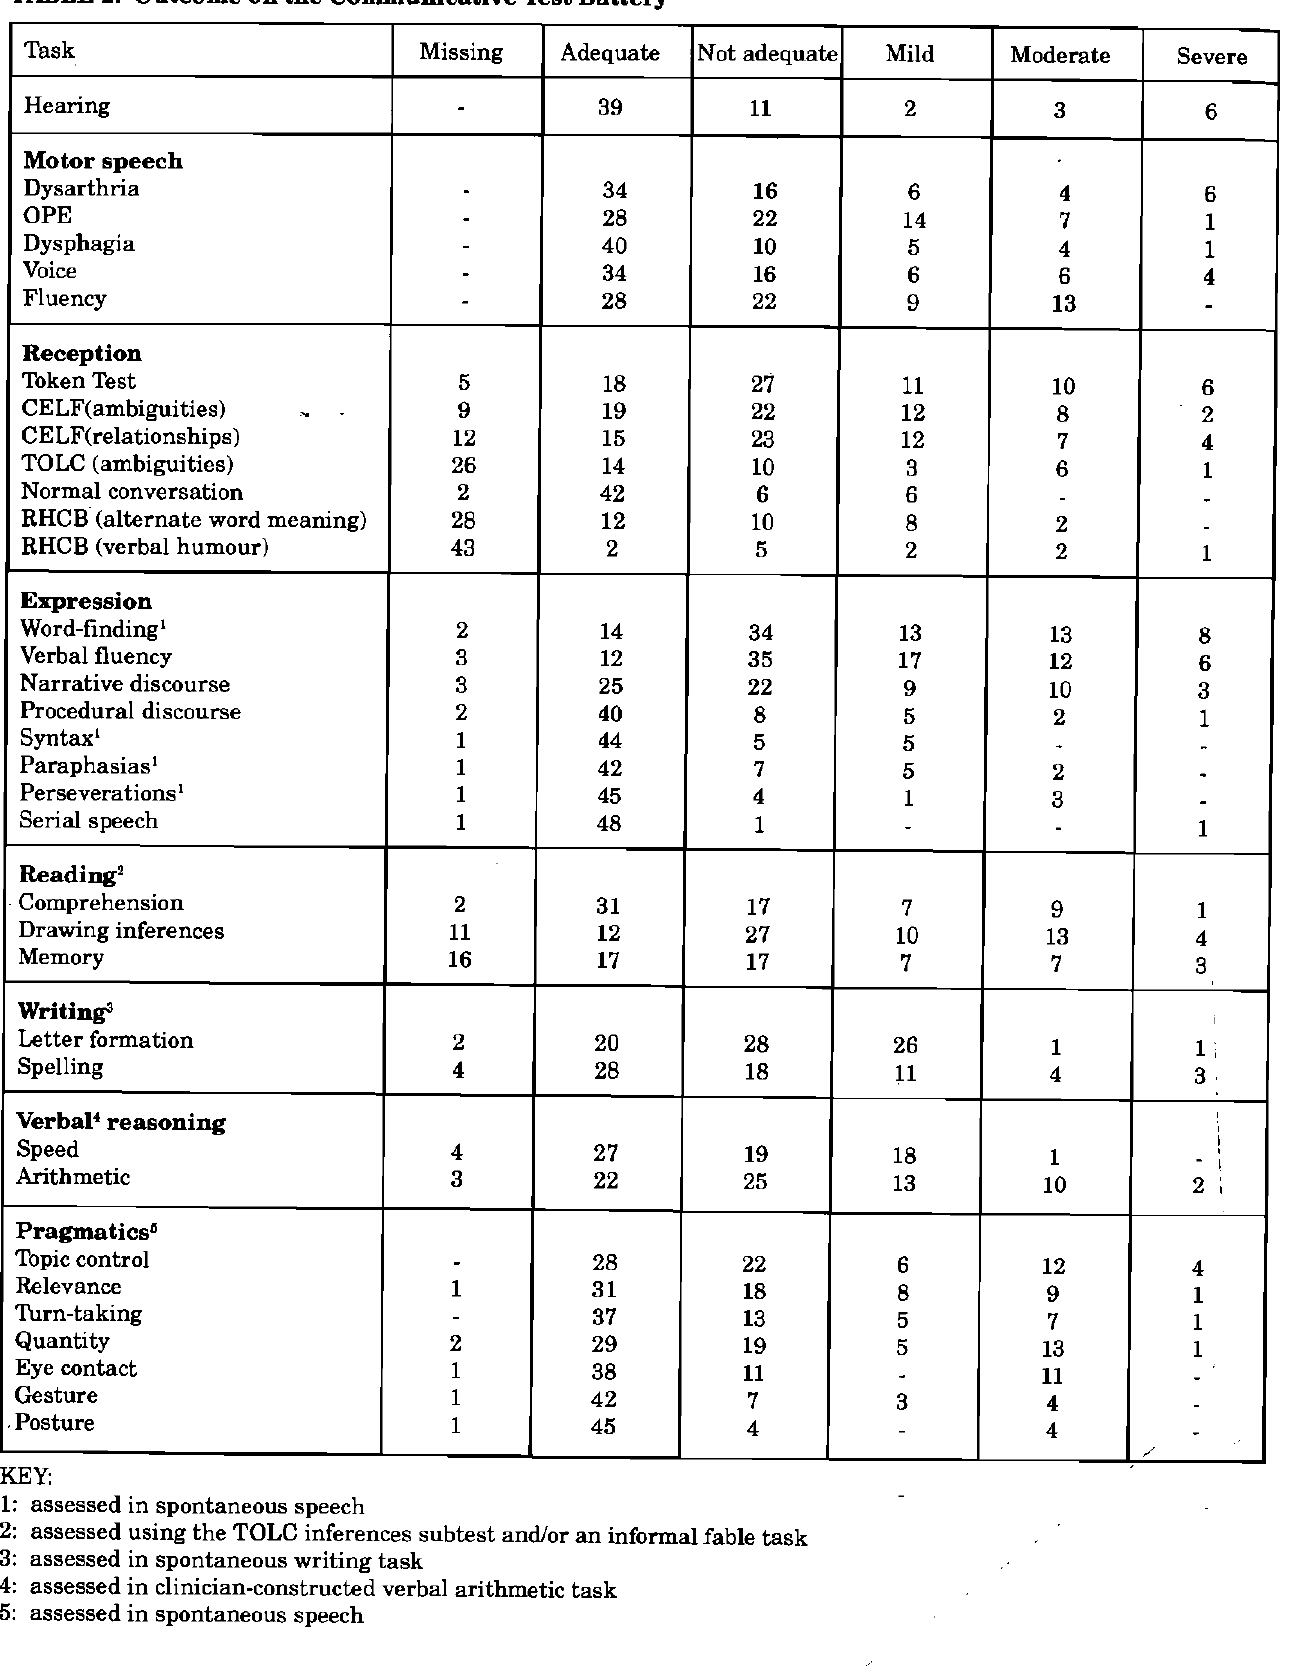
TABLE 2: Outcome on the Communicative Test Battery Task Missing